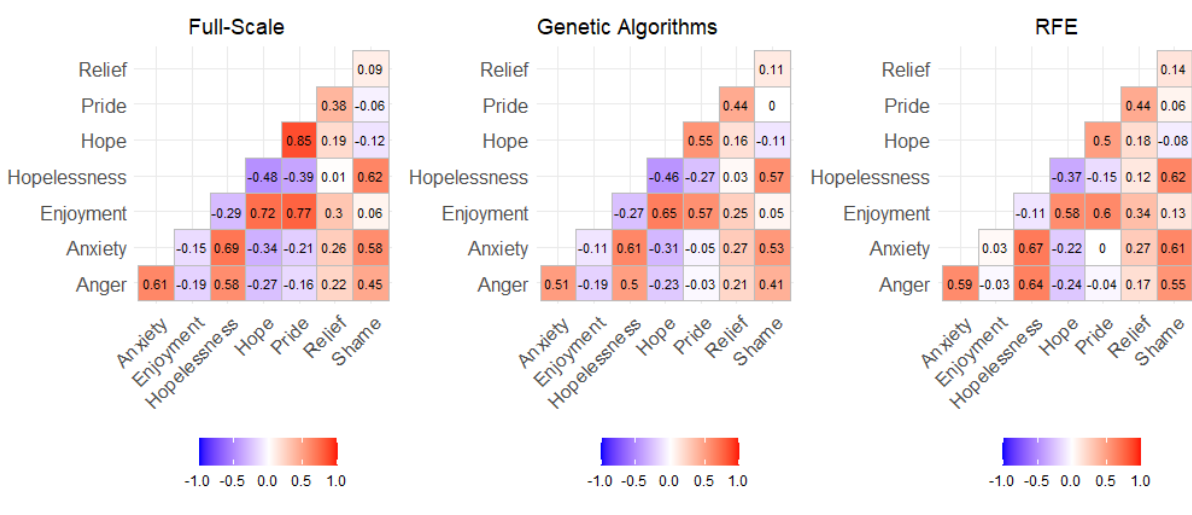
Figure 4. Correlations among the subscales of the